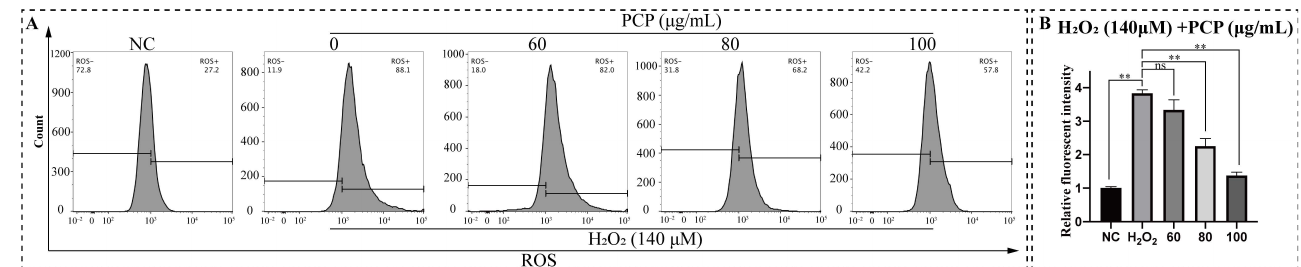
Figure 5. PCP scavenged H 2 O 2 -induced intracellular ROS in the microglia. The cells were treated with H 2 O 2 (140 µ mol) and PCP at different concentrations (0, 60, 80, and 100 µ g/mL) for 24 h. The NC group was set as the control and treated with DMEM medium. Then, we stained the cells using a DCFH-DA probe, detected them through a flow cytometer, and established the fluorescence intensity using FlowJo. ROS level in the microglia ( A ). The relative fluorescence intensity of ROS in the microglia ( B ). ( ns p > 0.05, and ** p < 0.01).